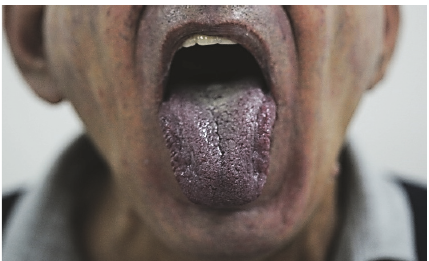
Figure 1: Central and peripheral cyanosis.